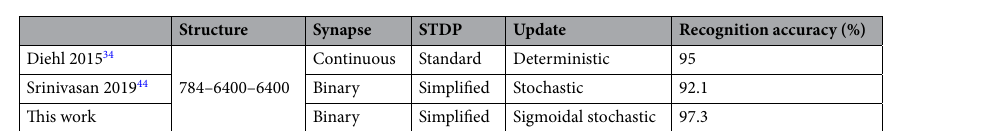
Figure 4. Recognition accuracy. ( a) Evolutions of recognition accuracy obtained using sigmoidal stochastic S-STDP with the number of learnings for k = 3 (with p = 0.13 and q = 0.03 ) and 4 (with p = 0.2 and q = 0.08 ) as well as those using conventional S-STDP ( k = 1 with p = 0.04 and q = 0.008 ) and deterministic S-STDP. The horizontal broken line indicates the 90% accuracy level. ( b) Comparison of the accuracies achieved in this work with previously reported values 34,44 . ( c) Relationship between the recognition accuracy and the number of neurons retaining their initially memorised digits after training with 150,000 samples. Data are obtained with various combinations of k , p and q . The broken line is a visual guide.